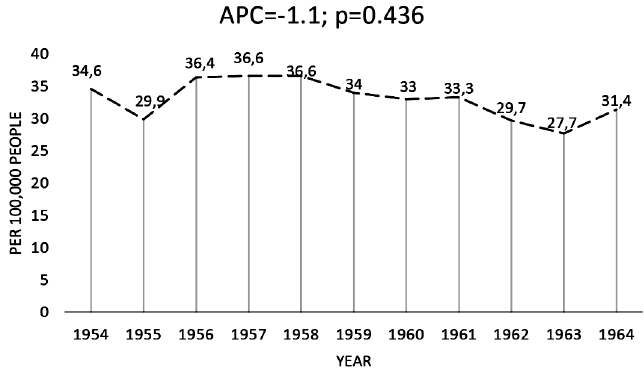
Figure 3. Syphilis incidence rates in the years 1954–1964